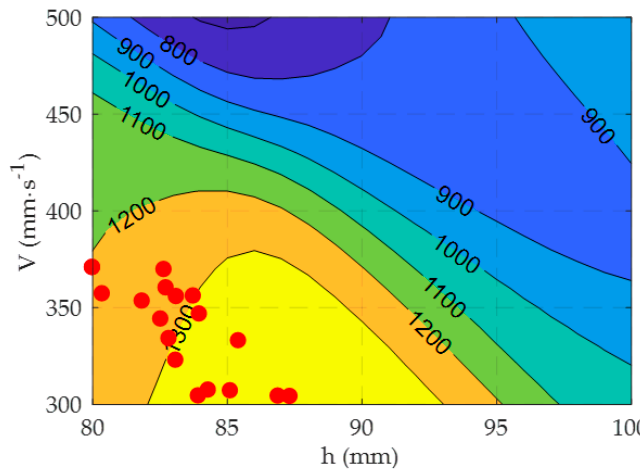
Figure 10. Contour plot of the function H (h, V) with optimal solutions (red dots). Figure 11. Contour plot of the function P (h, V) with optimal solutions (red dots).